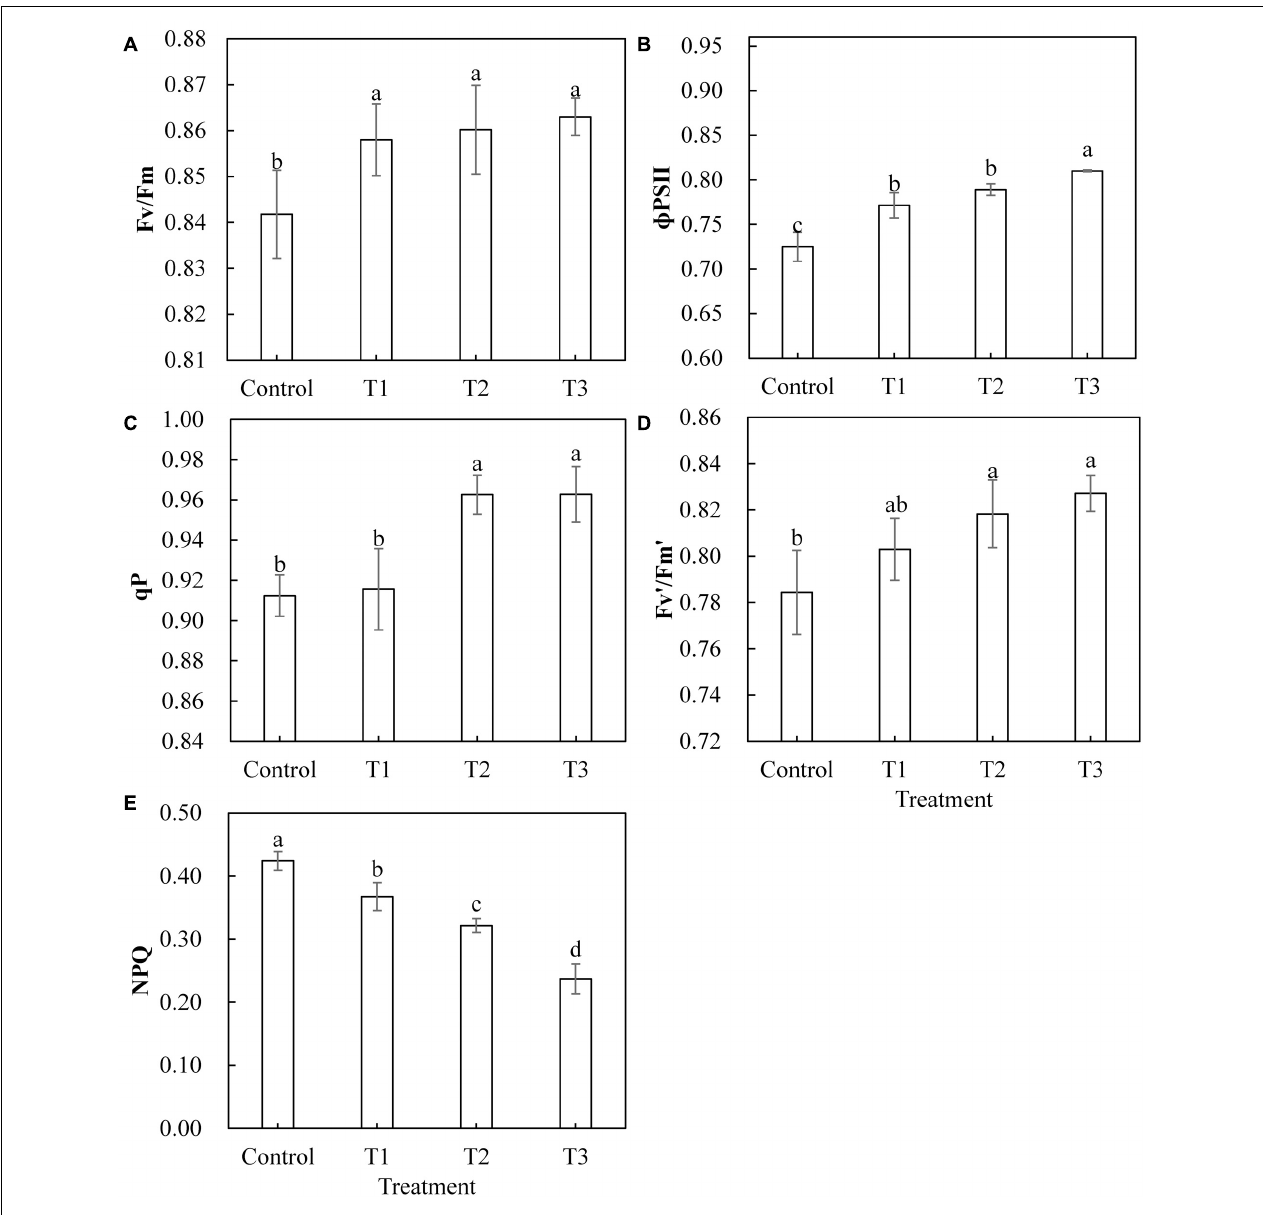
FIGURE 5 | Effects of supplemental LED light duration on the maximum photochemical efficiency of PS (cid:53) (A) , the quantum efficiency of PS (cid:53) photochemical center (B) , the photochemical quenching coefficient (C) , the efficiency of excitation energy captured by open PS (cid:53) reaction centers (D) , and the non-photochemical quenching coefficient (E) in cucumber leaves. After LED treatment for 30 days, chlorophyll fluorescence parameters of cucumber leaves were measured using chlorophyll fluorescence analyzer after 30 min of dark adaptation. Values are expressed as mean ± SE ( n = 3). Bars that are significantly different based on the Duncan’s multiple range test ( p < 0.05) are indicated with different lowercase